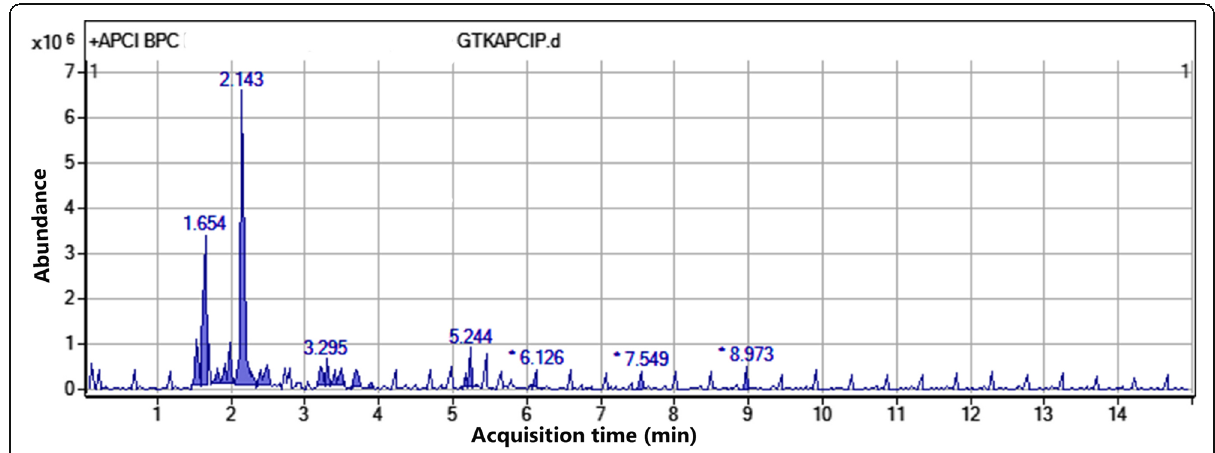
Fig. 3 APCI-MS-base peak chromatogram of GTK in positive